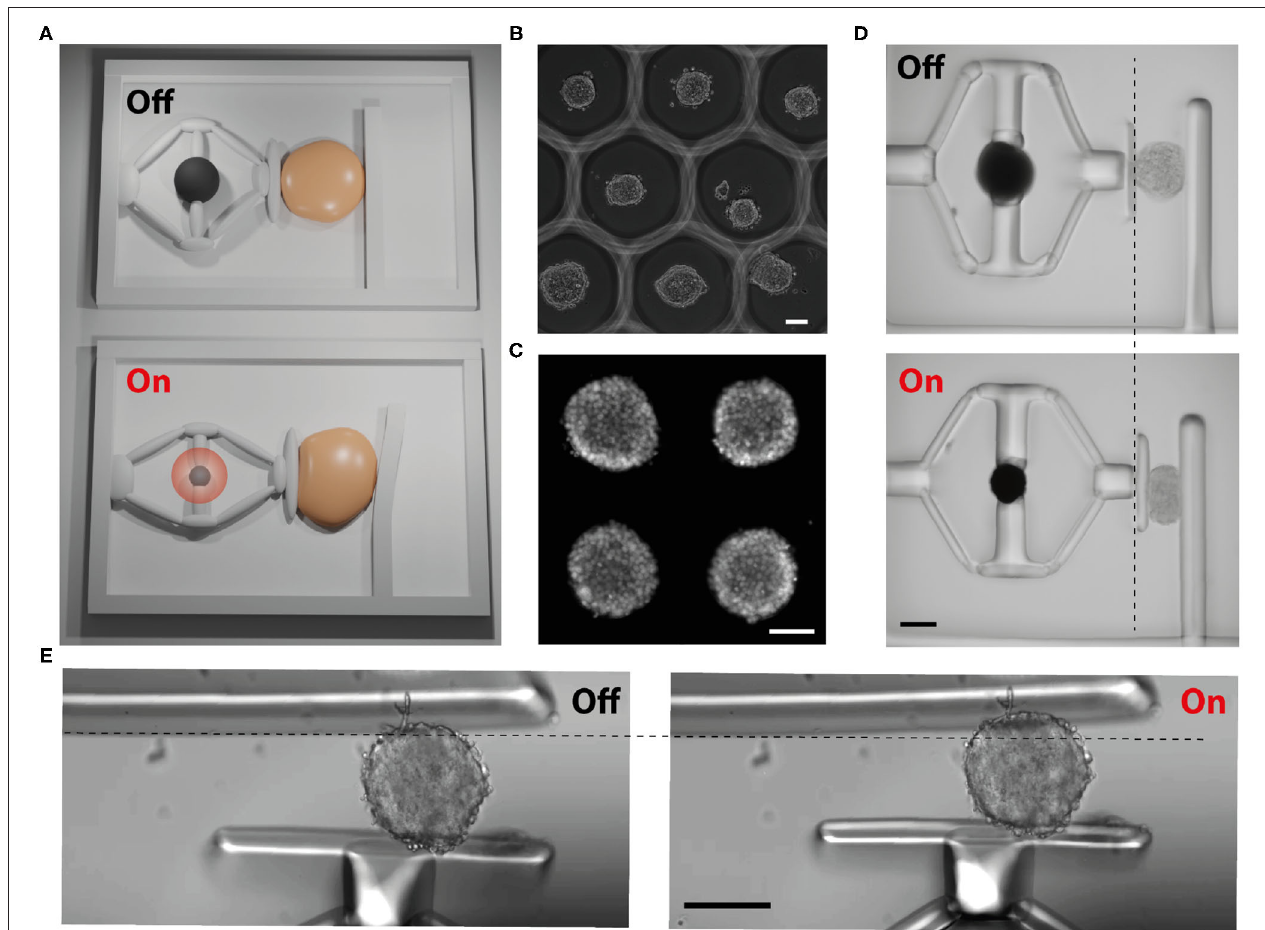
FIGURE 5 | Biomechanical characterization of 3D tissue samples. (A) Schematic depiction of the working principle (not to the scale). Upon application of NIR illumination, the monolithic compliant mechanism deforms and the piston compresses the sample. The cantilever beam reports the sample stiffness. (B) Phase-contrast image shows high-throughput fabrication of spheroids using hydrogel wells. (C) Fluorescent image of an array of self-assembled spheroids labeled with a DNA dye. (D) Snapshots from a representative compression experiment where the deflection of the beam is not obvious. (E) A compression device with a more sensitive cantilever beam. The beam deflects during the loading of the sample, reporting its stiffness. Scale bars, 100 µ